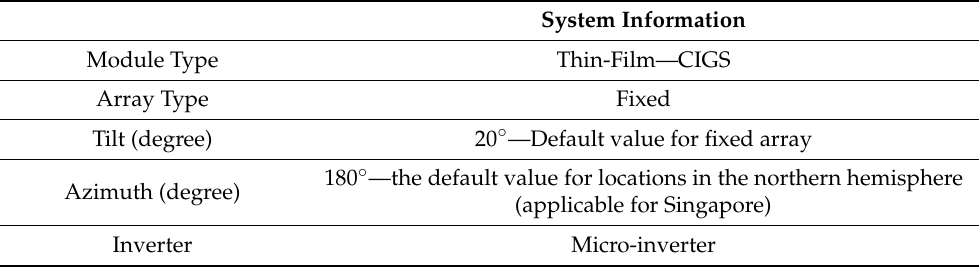
Table 3. PV system